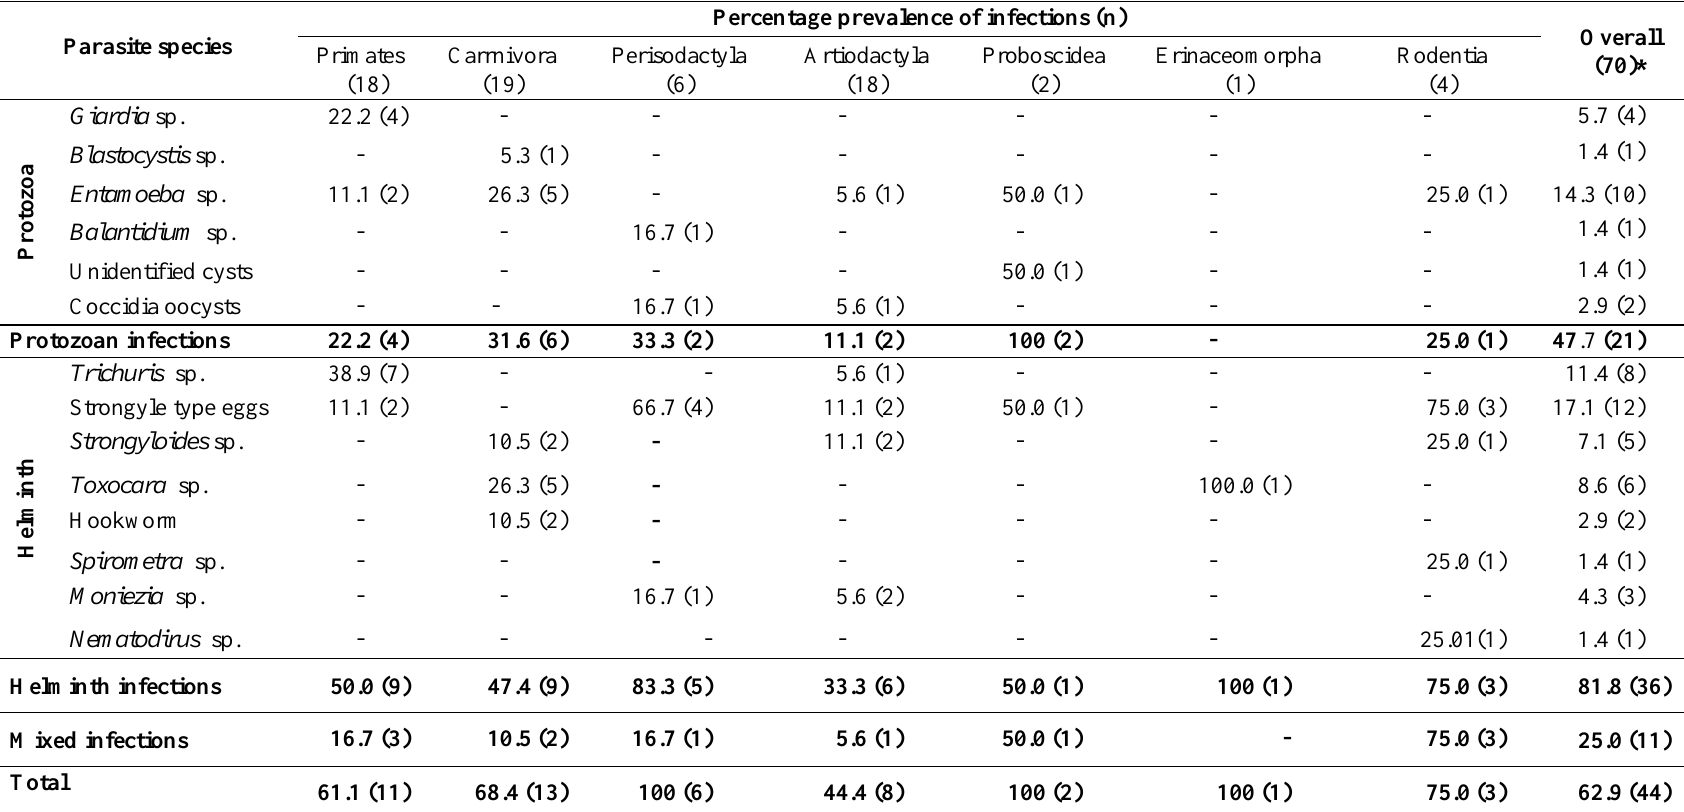
Table 2: Prevalence of different types of gastrointestinal parasites in seven mammalian orders in the Dehiwala Zoo